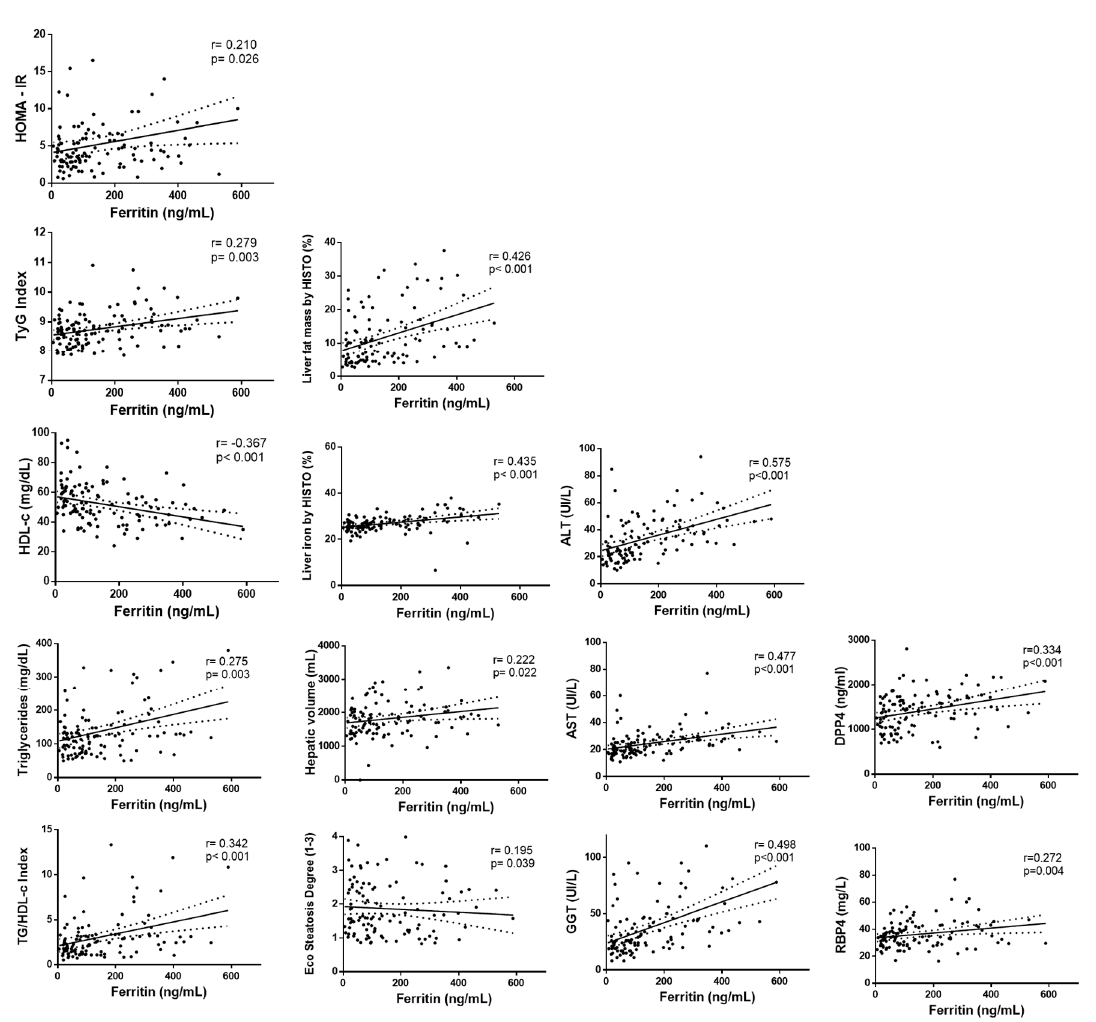
Figure 1. Correlation analyses between serum ferritin levels with liver status and glucose metabolism-related markers. First column: HOMA-IR, TyG index, HDL-c, triglycerides, TG/HDL-c. Second column: liver fat mass, liver iron, hepatic volume, steatosis degree. Third column: ALT, AST, GGT. Fourth column: DPP4 (dipeptidyl-peptidase 4), RBP-4 (retinol-binding protein 4).